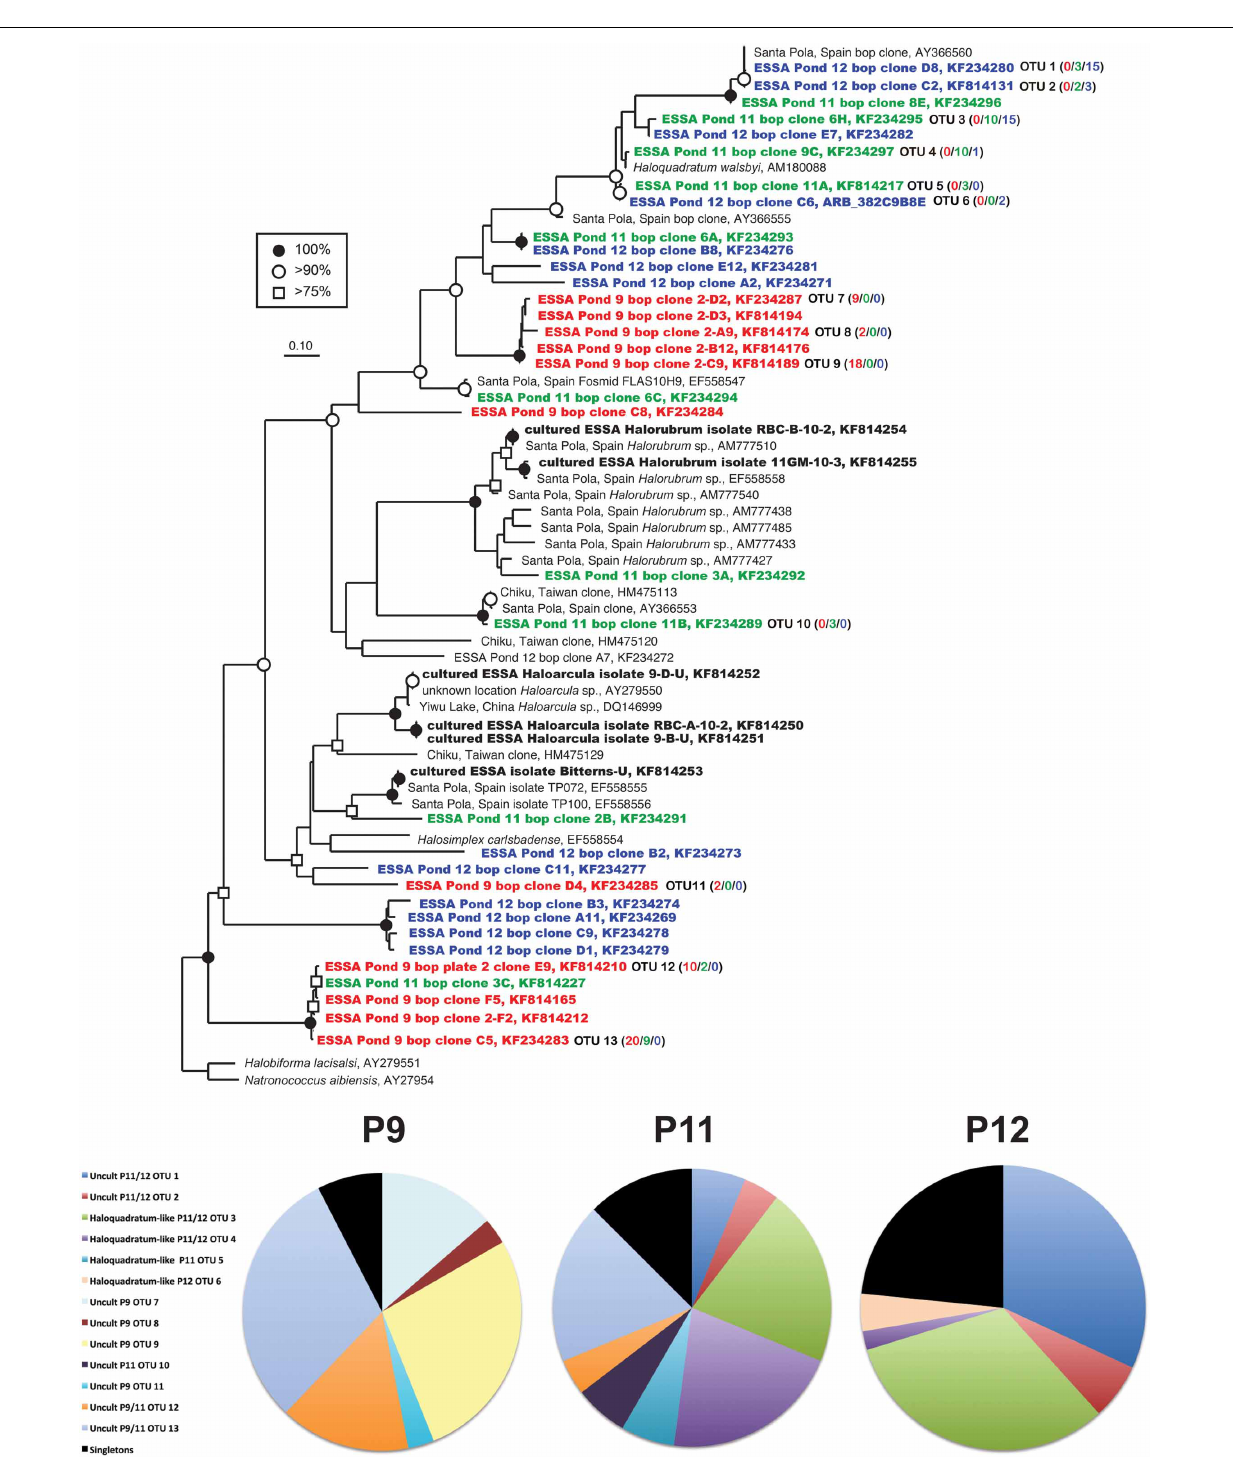
( (cid:2) ), 90% ( ◦ ), and 100% ( • ) for maximum likelihood trees (550 replicates). For OTU ( ≥ 99% similarity) containing more than 1 sequence, the number of duplicates from each pond (9/11/12) is shown in parentheses. Halobiforma lacisalsi and Natronococcus aibiensis sequences were used as outgroups. Pie charts show the relative representation of each of the identified OTUs for each pond, with those found only once (singletons) grouped. Legend is for all three